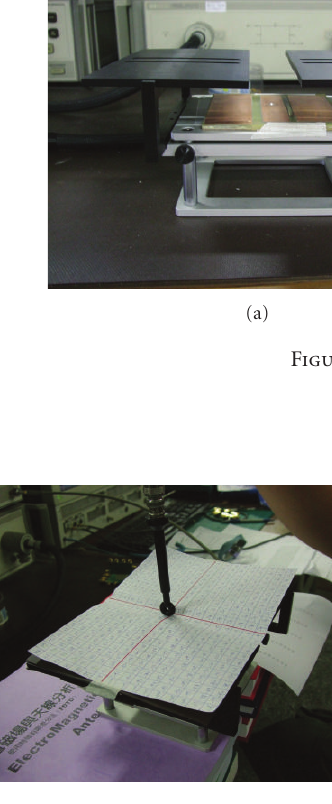
Figure 9: Measurement of the proximity field on the platform